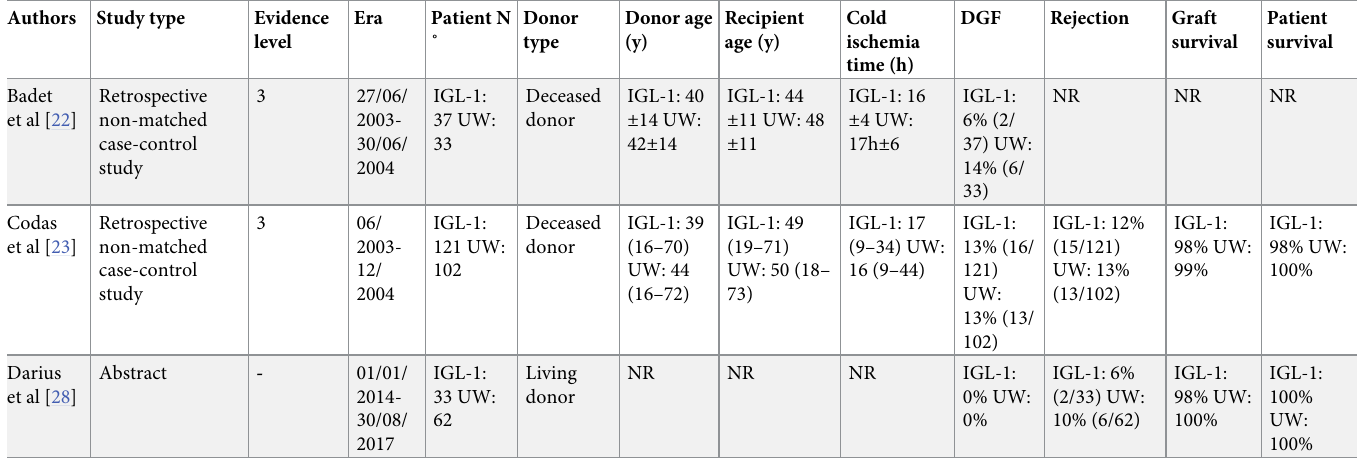
Table 2. Overview of outcome measures for the articles reporting on kidney